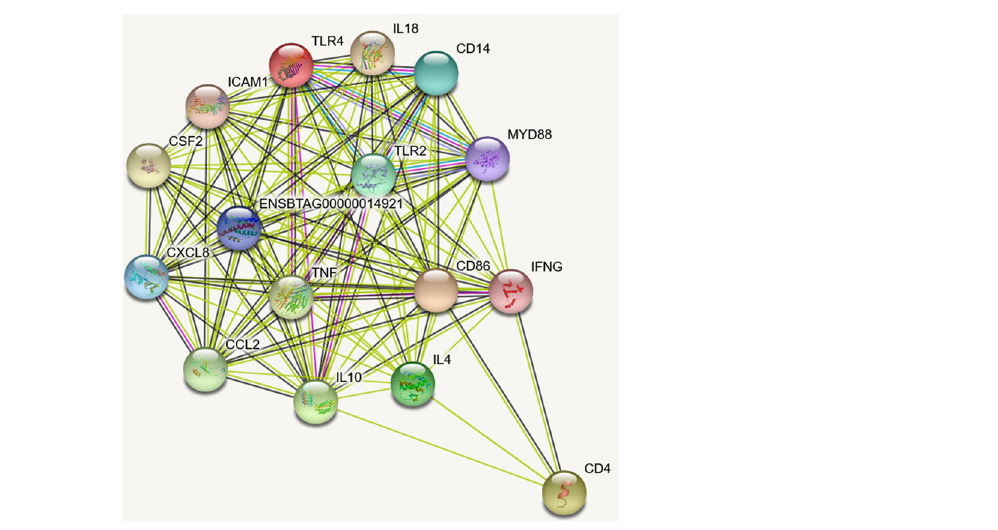
Figure 2. Network of 16 target bovine mastitis genes created using STRING (string-db.org). The Ensembl ID in the network refers to IL-6. Edge color legend (blue: from curated database, pink: experimentally determined, green: text mining, brown: